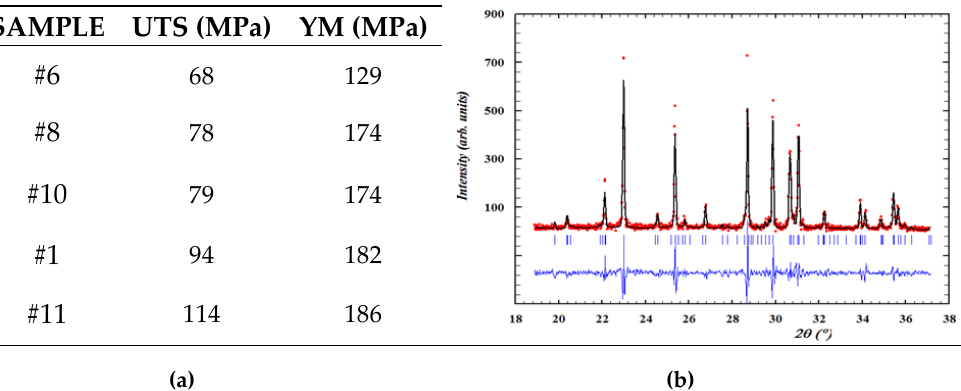
Figure 9. Image of the LYSO crystal surface acquired by a scanning electron microscope (SEM). TEM measurements were performed on all five samples and the absence of lattice defects, in four out of the five samples, was confirmed by high-resolution analysis (Figure 10a). A completely different microstructure has been revealed in sample #6, the one with the lowest UTS and YM values.